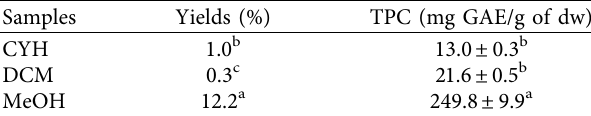
Table 1: Yields and TPC in the aerial part of R. crispus extracts.